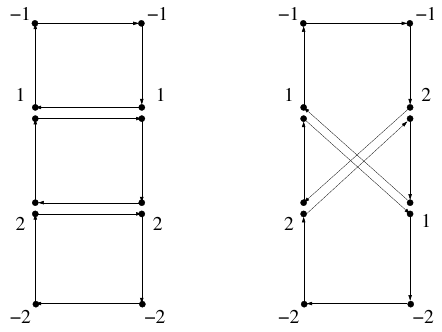
Figure 1 . Colour loop sets for 0 → q ¯ qgg : L ( γ 1 , γ 1 ) (left) and L ( γ 1 , γ 2 )